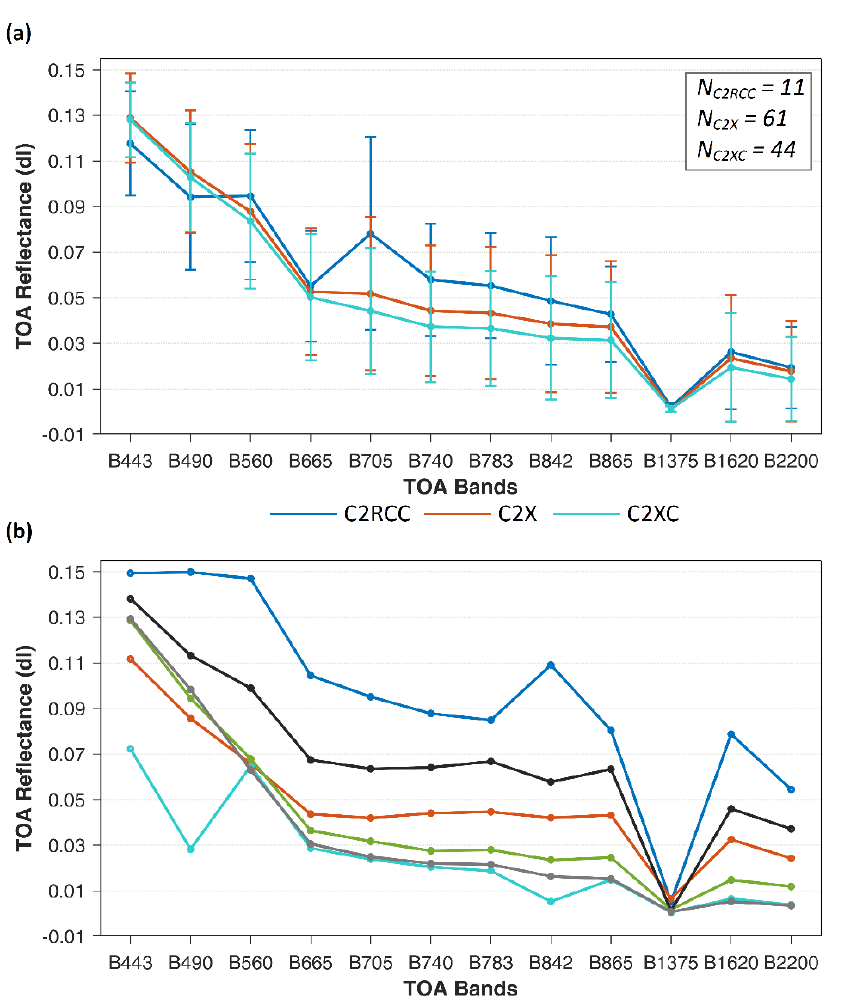
Figure 7. ( a ) Mean (lines) and standard deviation (bars) of TOA reflectance spectrums describing, by C2-Net, the set of rejected pixels during the match-up exercise steps ii–v; ( b ) Mean TOA spectrums of rejected pixels in all C2-Nets. Rejected pixels of the C2-Nets flags are not included. Table 6. Summary of validation of [Chl -a ], [TSM], and Kd_z90max derived from C2-Nets. m and b stand for slope and intercept of the linear